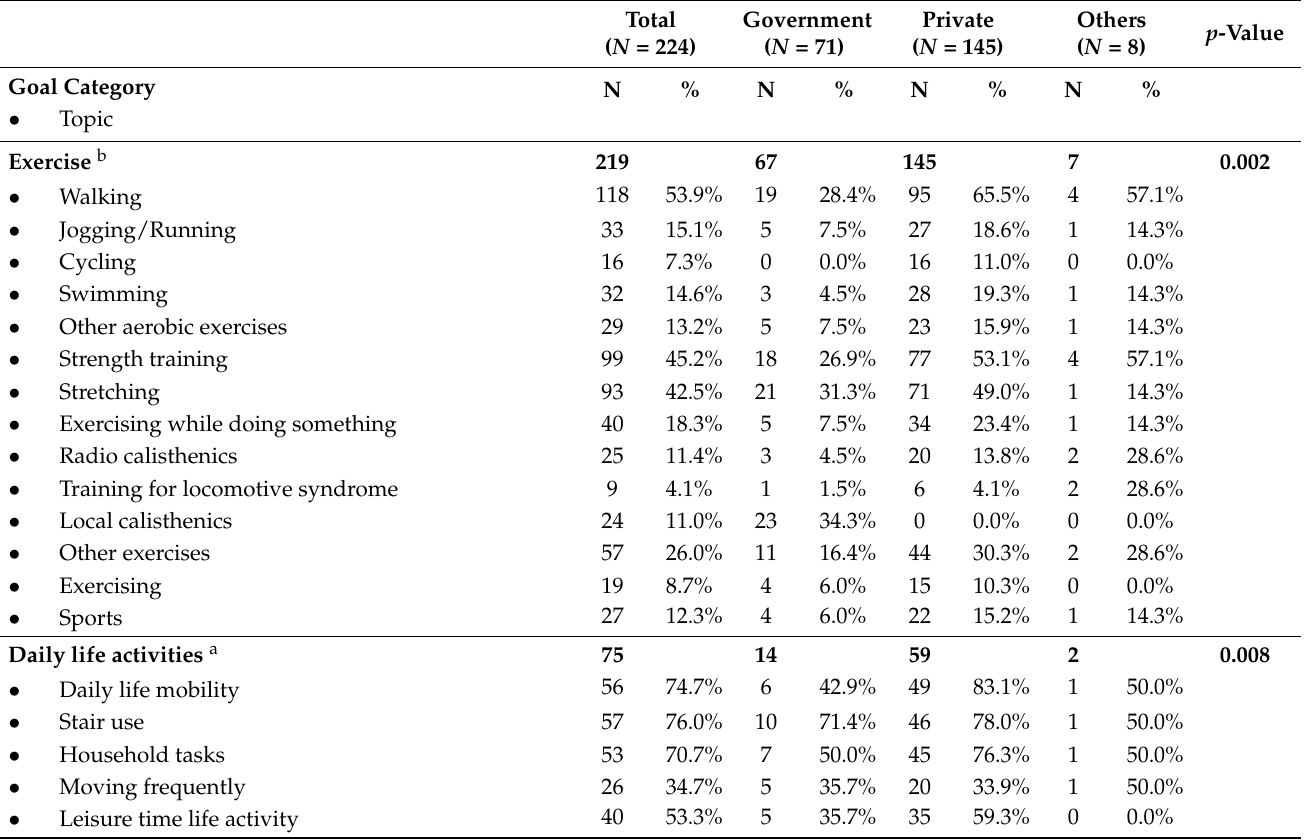
Table 5. Categories and Topics of Subordinate Goals in the PA Print Materials by Publisher ( N =